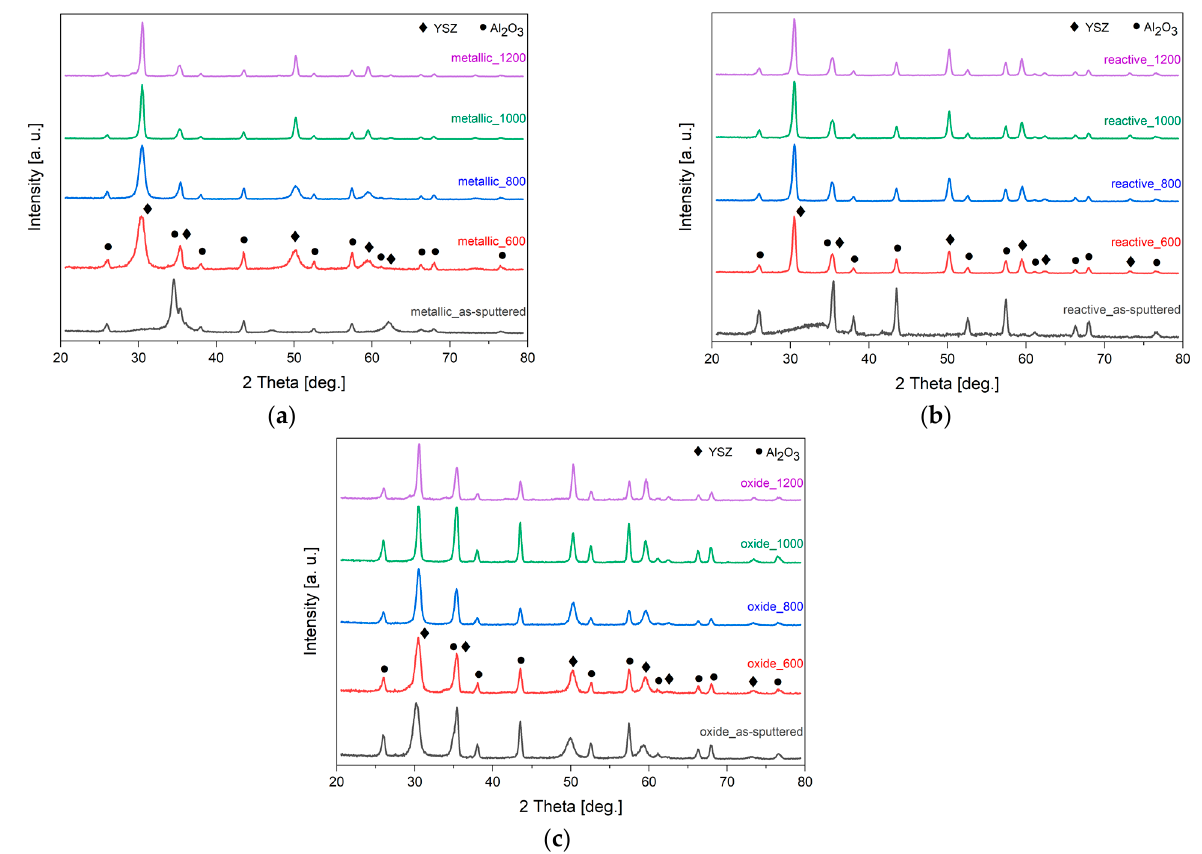
Figure 3. GIXRD of the sputtered 10YSZ films before and after the annealing treatment: ( a ) dc-metallic; ( b ) dc-reactive; and ( c ) rf-oxide. The reflections belonging to the Al 2 O 3 substrate and the YSZ are marked by ( ● ) and ( ♦ ), respectively. Table 2. Calculated grain size in nm using the Scherrer equation and the (111)